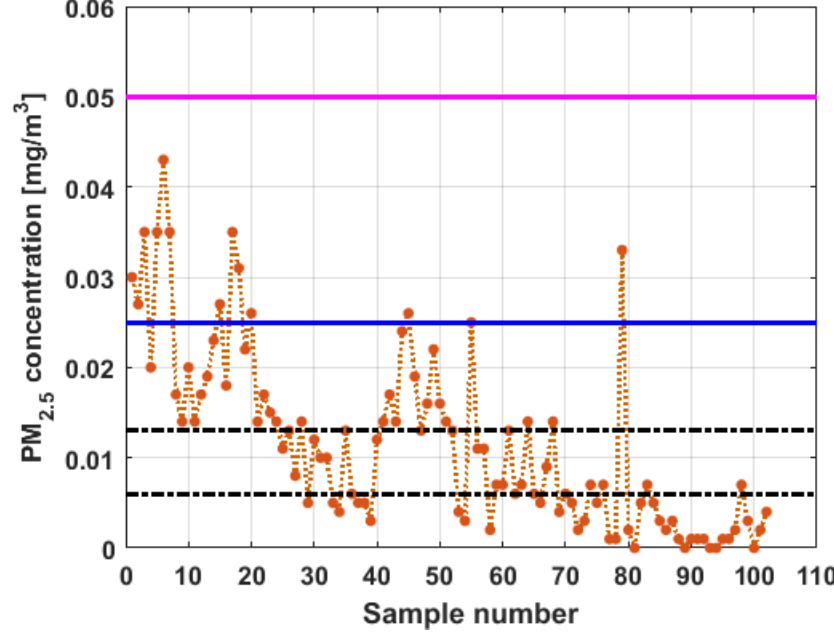
Figure 13. Observations of variable X 3 , together with the 95% nonparametric confidence interval for the median (shown with dashed black lines) and the limits that define the categories of the level of air pollution by PM 2.5 (Desirable level: Blue line; Acceptable level: Magenta line).